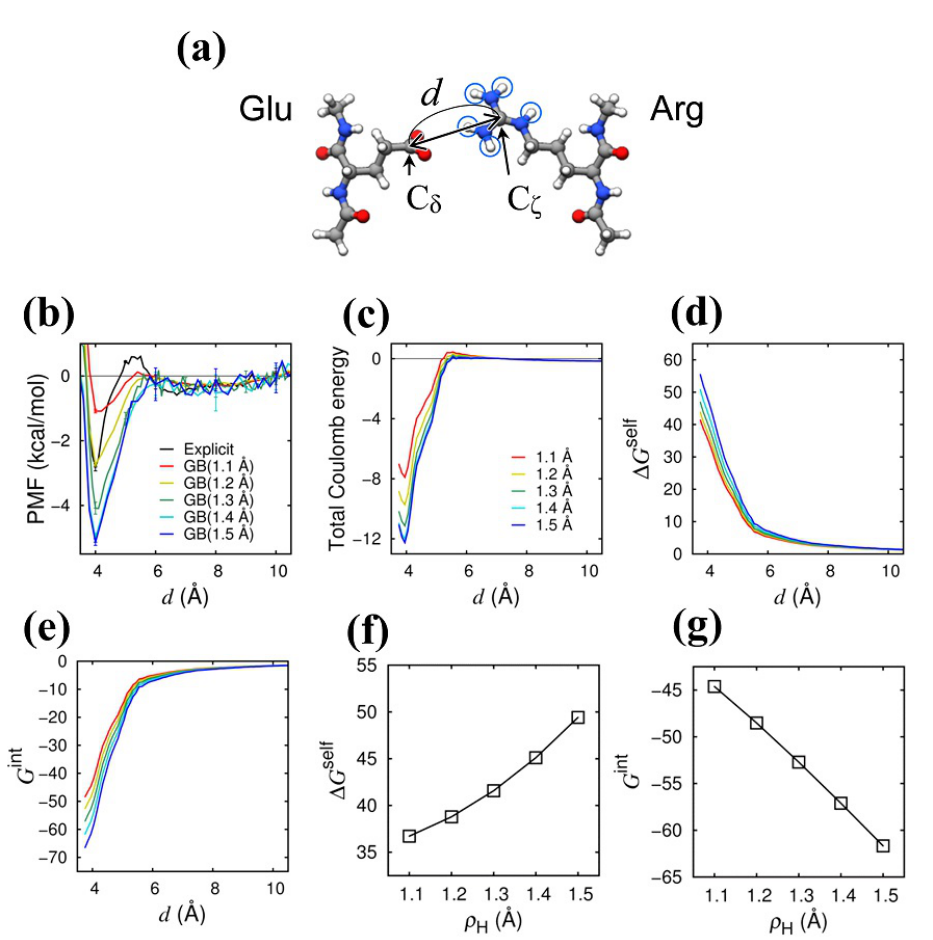
Figure 2. Author request: Please enlarge the figure size for visibility (we changed the ration from 0.8 to 0.95 Effect of ρ H on Coulomb energies in Arg–Glu system. ( a ) Illustration of the system. Encircled hydrogen atoms in the guanine group of Arg are the atoms, the intrinsic radii of which ( ρ H ) were uniformly and systematically changed from 1.1 Å to 1.5 Å. ( b ) Potential of mean force (PMF) is shown as a function of d [see ( a )] for the explicit water model (black) and for the GB solvation model at different ρ H values (1.1 to 1.5 Å). ( c ) Total Coulomb energy ( ∆ G self + G int ), ( d ) total desolvation energy ( ∆ G self ), and ( e ) total Coulomb interaction energy ( G int ) are shown as a function of d at different ρ H values [line colors correspond to those in ( c )]. ( f ) Total desolvation energy ( ∆ G self ) and ( g ) total interaction energy ( G int ) averaged in the range of 3.9 ≤ d ≤ 4.0 Å are shown as a function of ρ H . Energy unit is